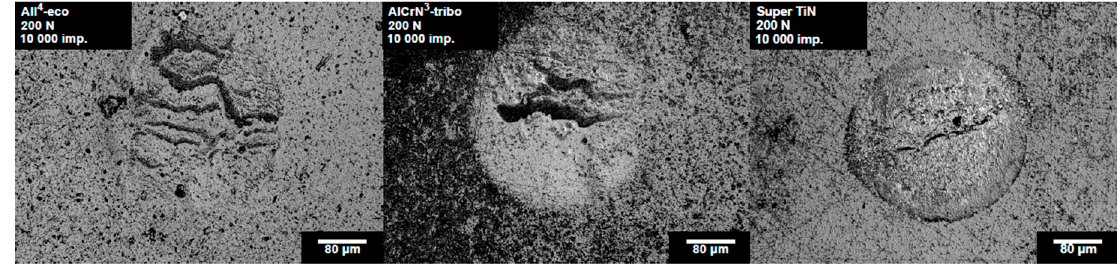
Figure 6. Impact craters of the tested PVD coatings obtained by 10,000 impacts and a load of 200 N.